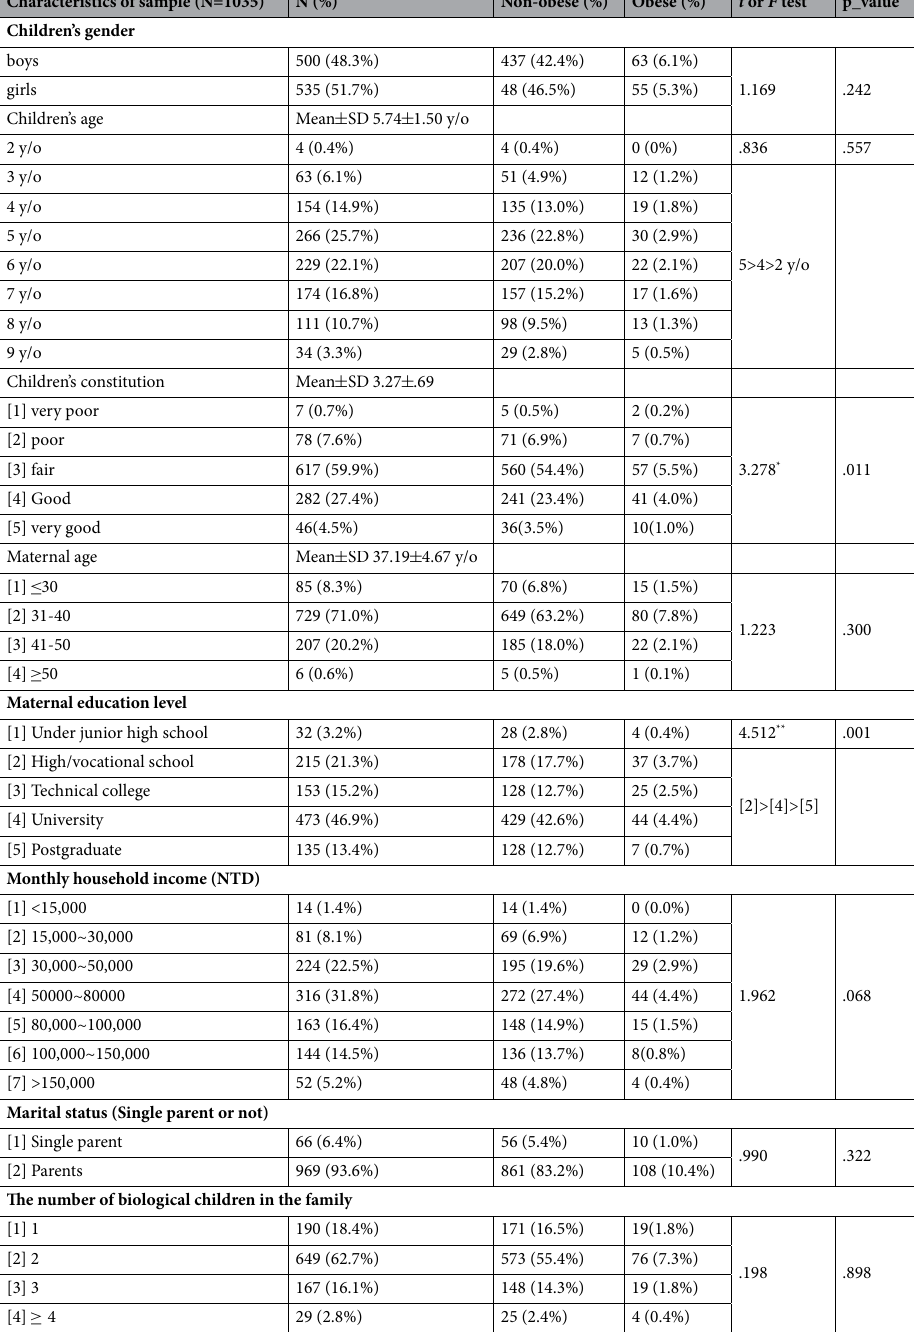
Table 1. Demographic characteristics of the children and mothers in the study. *p < 0.05; ** p < 0.01; *** p <